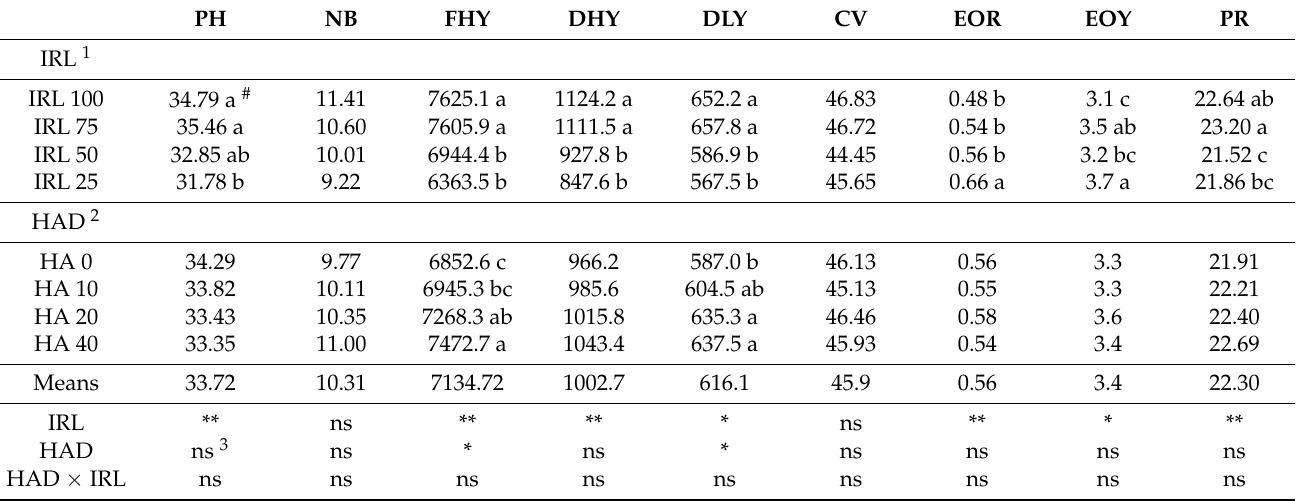
Table 1. Analysis of variance and mean values of the examined morpho-physiological characteristics of Ocimum basilicum L. cultivated under different IRL and HAD conditions (2016) without SM.